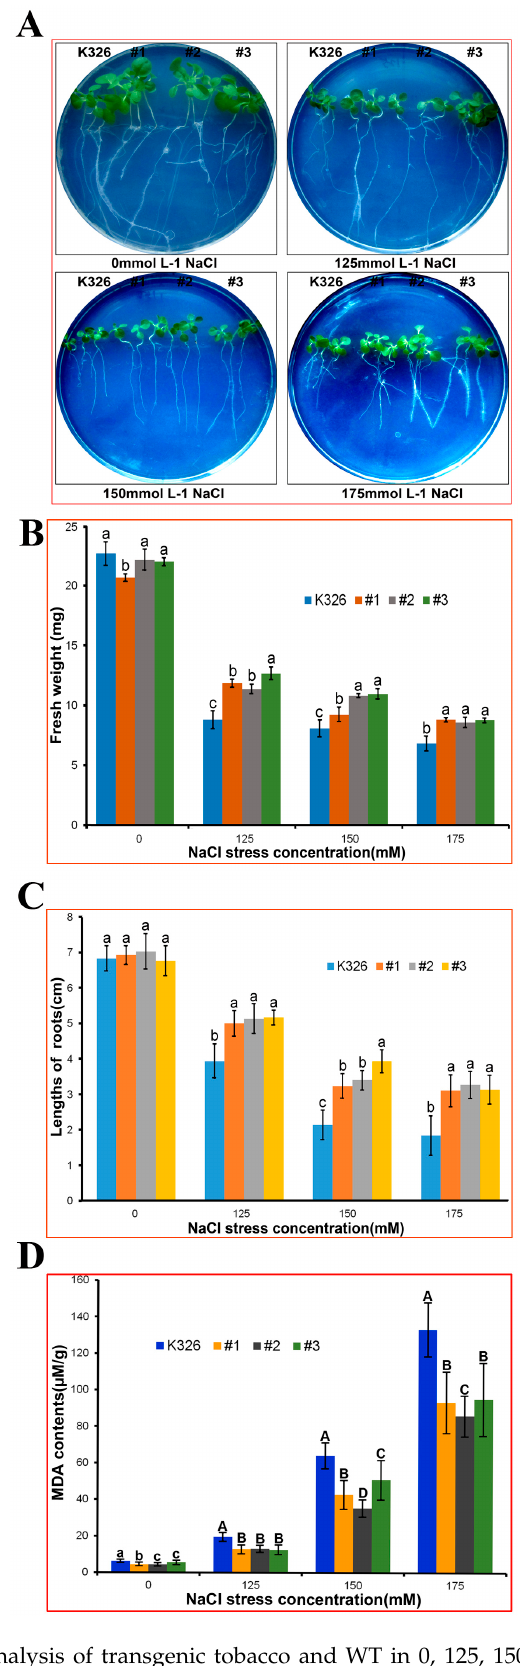
Figure 8. Resistance analysis of transgenic tobacco and WT in 0, 125, 150, and 175 NaCl culture after germination for 9 days ( A ). Fresh weight ( B ); lengths of roots ( C ); and MDA contents ( D ) were measured separately. Differences were analyzed by ANOVA ( p <0.05).